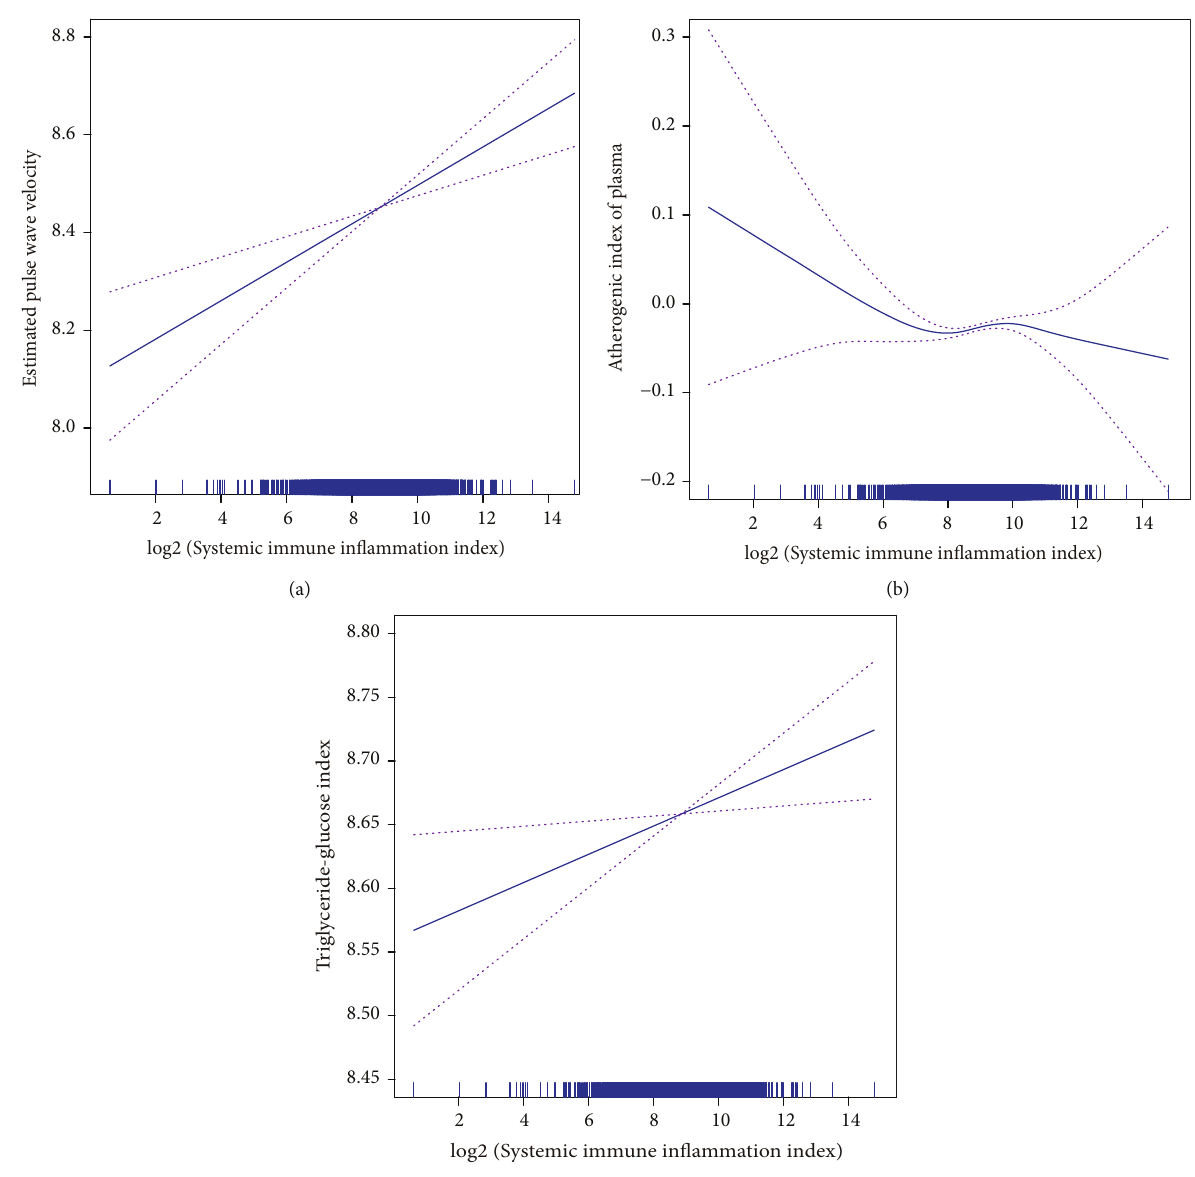
Figure 1: The generalized additive models of the association between SII index with (a) estimated pulse wave velocity, (b) atherogenic index of plasma, and (c) triglyceride-glucose index. Abbreviation: SII: systemic immune in fl